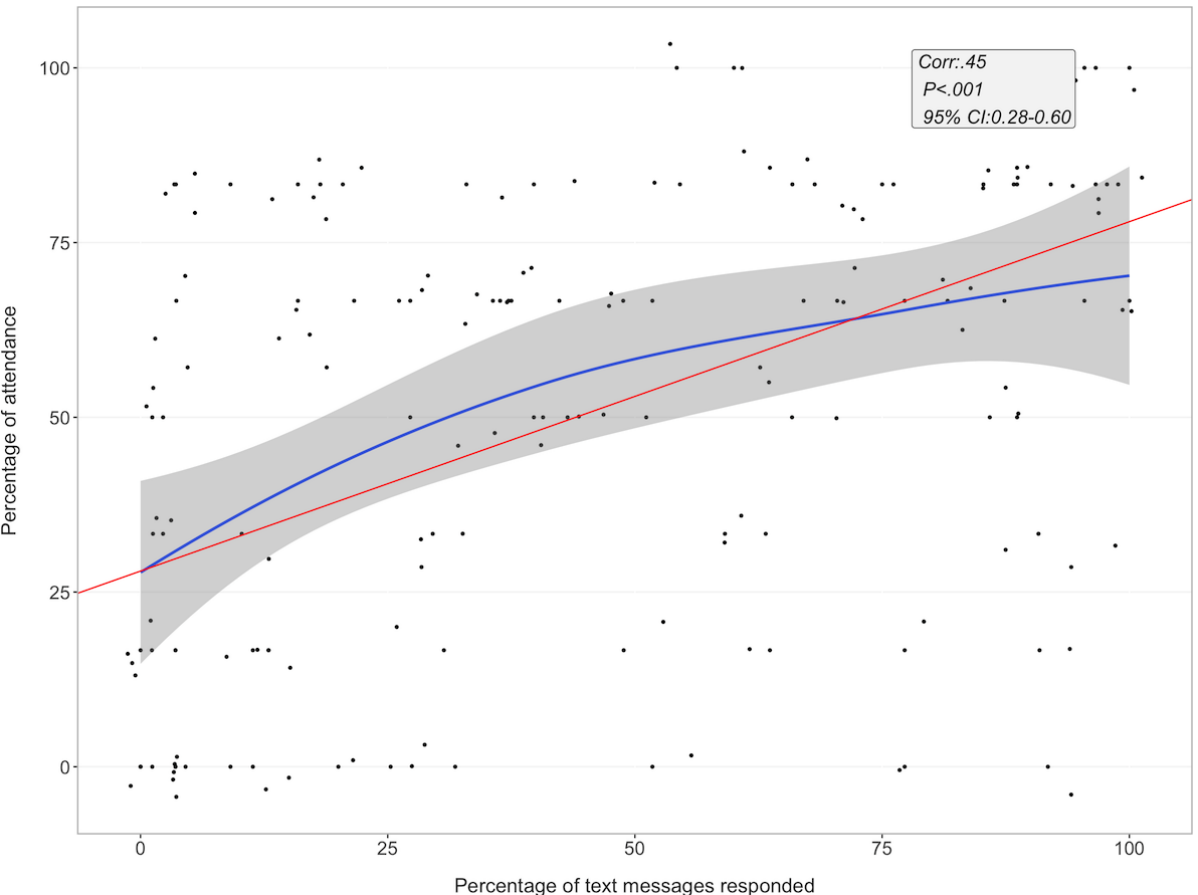
Figure 2. Electronic message response rate and class attendance after 6 months. Blue line denotes loess line fit and red line denotes linear regression line fit. E-message: electronic message; Corr: